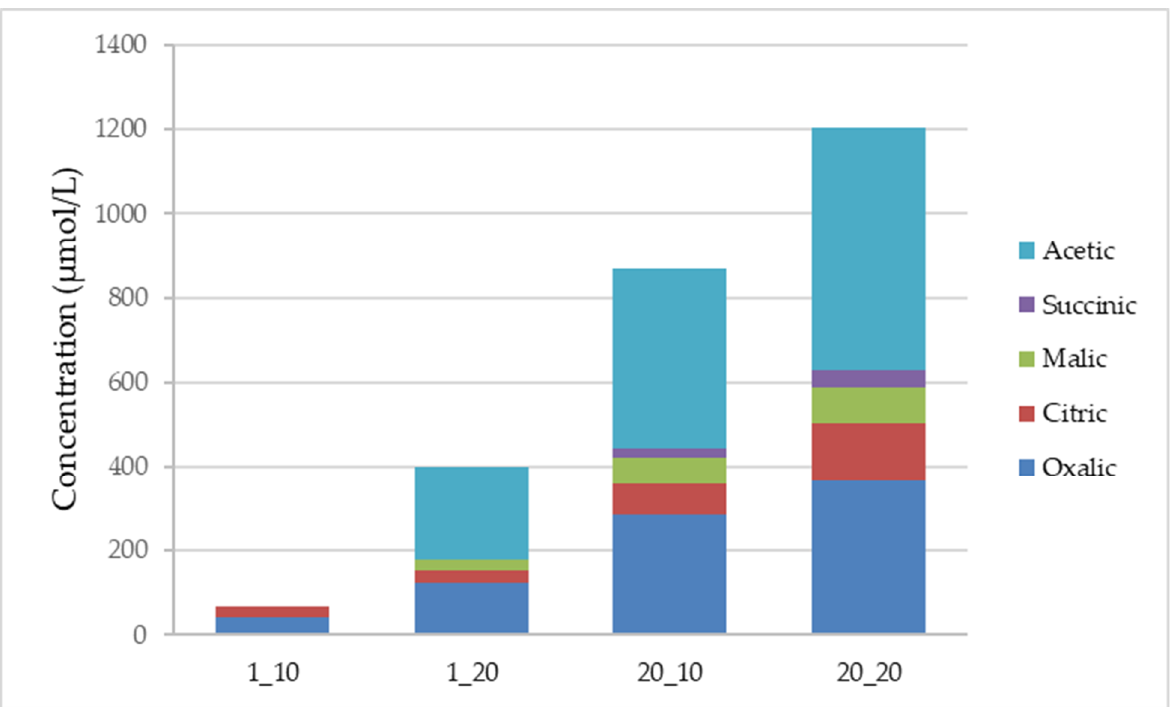
Figure 4. Organic acid production by Acetobacter tropicalis in bioleaching experiments of 1% S/L- BR pulp density with 10 and 20% w / w of bacterium suspension in 1 and 20 d. (e.g., exp., 1_10: 1% S/L-pulp density of BR, 10% w / w bacterium suspension) .